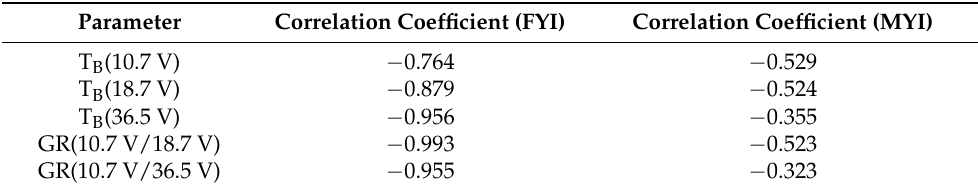
Table 3. Correlation coefficients between TBs (GRs) and snow